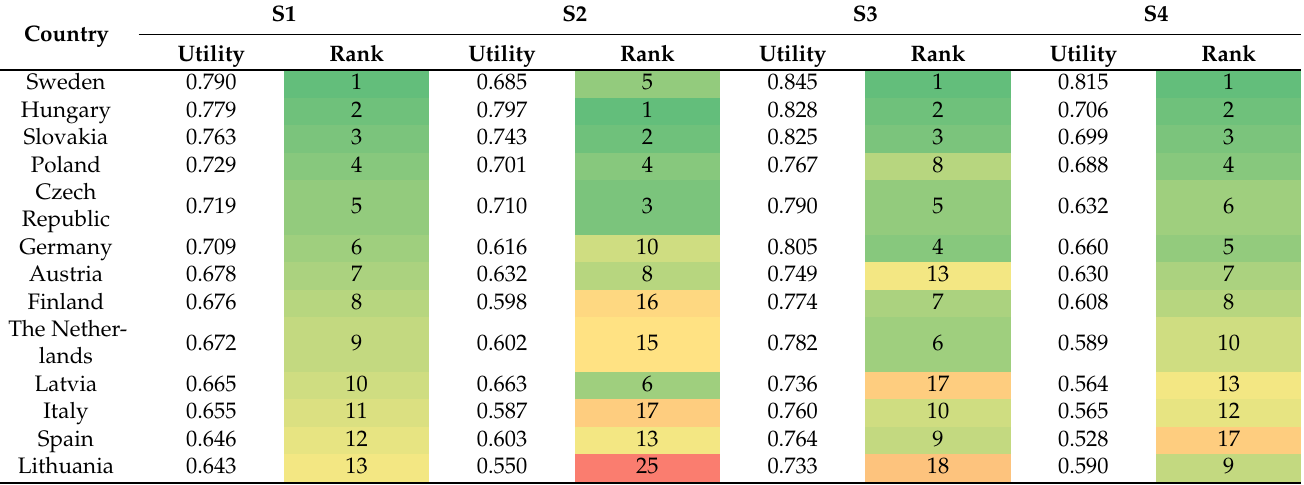
Table A3. Results and comparison of different weighting scenarios,